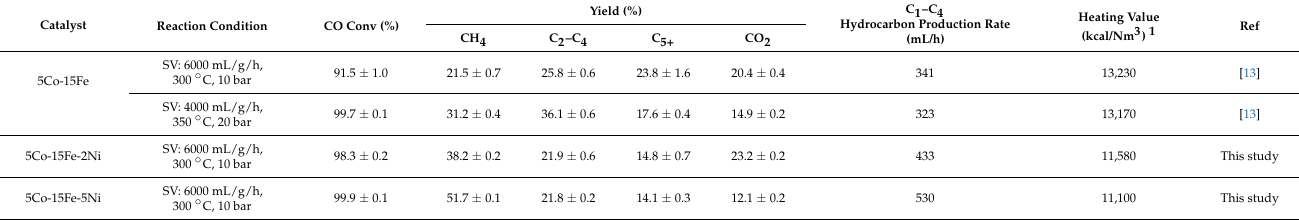
1 The heating value of each product gas was determined from the volumetric hydrocarbon fraction by calculating the heating values of the pure gases in the C 1 –C 4 hydrocarbon range in the outlet